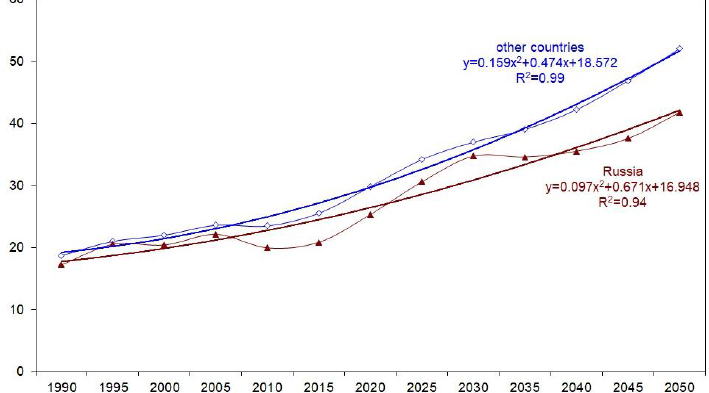
Fig. 1. Estimated and forecasted old-age dependency ratio values (Source: United Nations, 2019a)